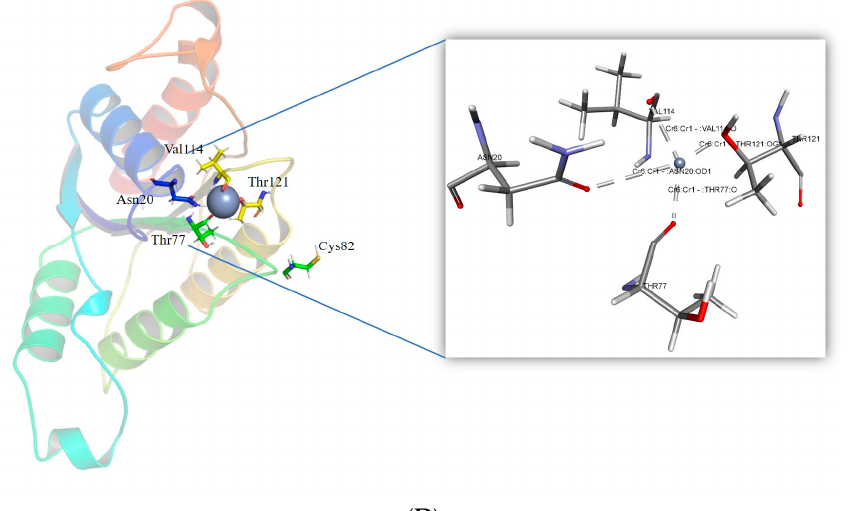
Figure 6. Intra-molecular interactions formed between Cr(VI) and the binding pocket residues of ChrR ( P. alcalifaciens ). ( A ) Interaction of Cr(VI) with ChrR wild type, ( B ) interaction of Cr(VI) with mutant ChrR Glu144Trp, ( C ) interaction of Cr(VI) with mutant ChrR Gln126Trp, and ( D ) interaction of Cr(VI) with mutant ChrR Arg82Cys.